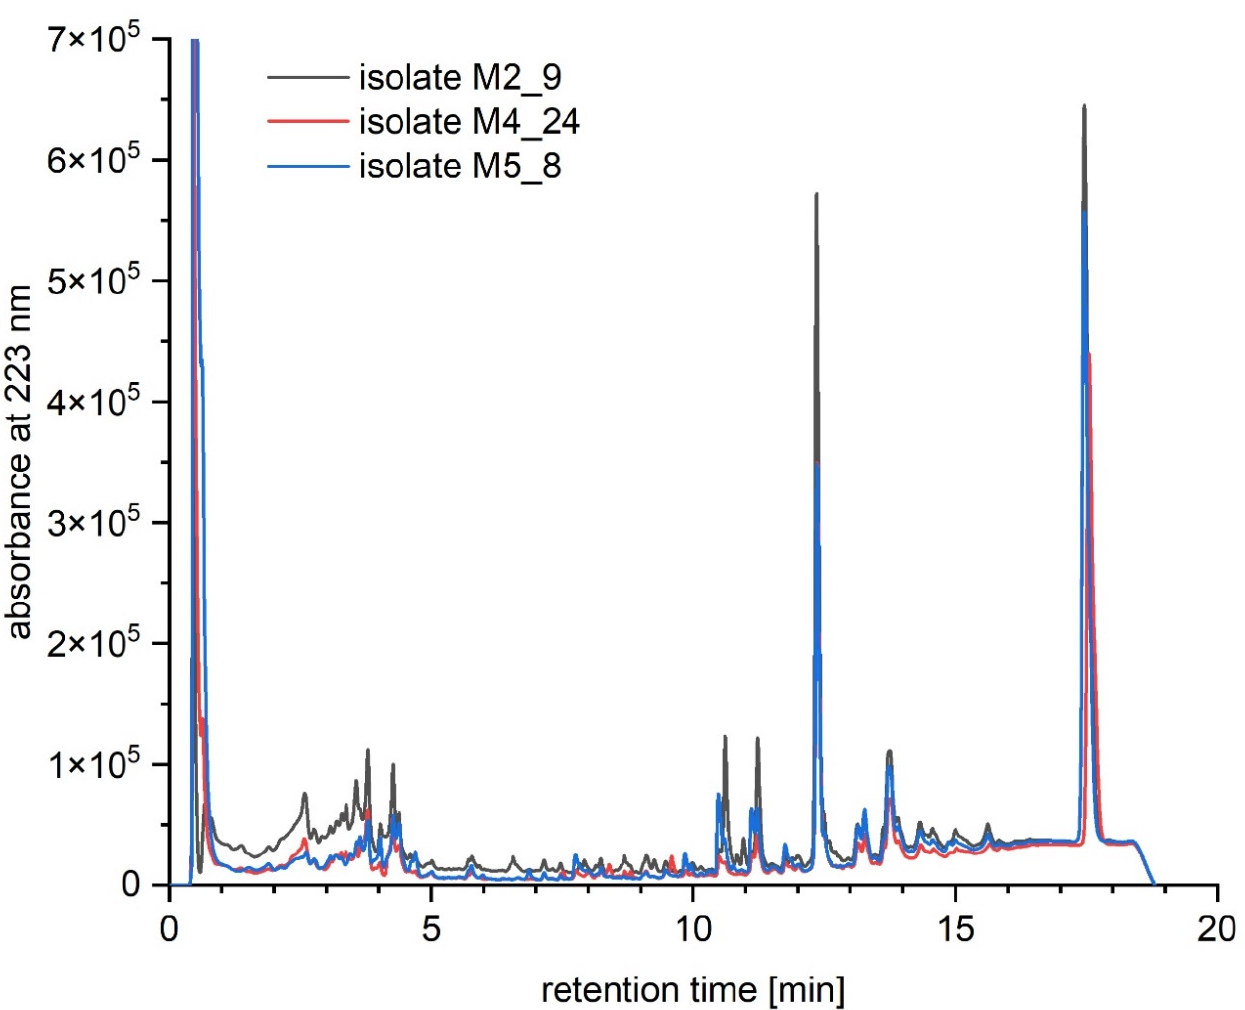
Figure 6. Overlayed chromatograms obtained by UHPLC of crude extracts of cultures of Streptomyces isolates M2_9 (black), M4_24 (red), M5_8 (blue).